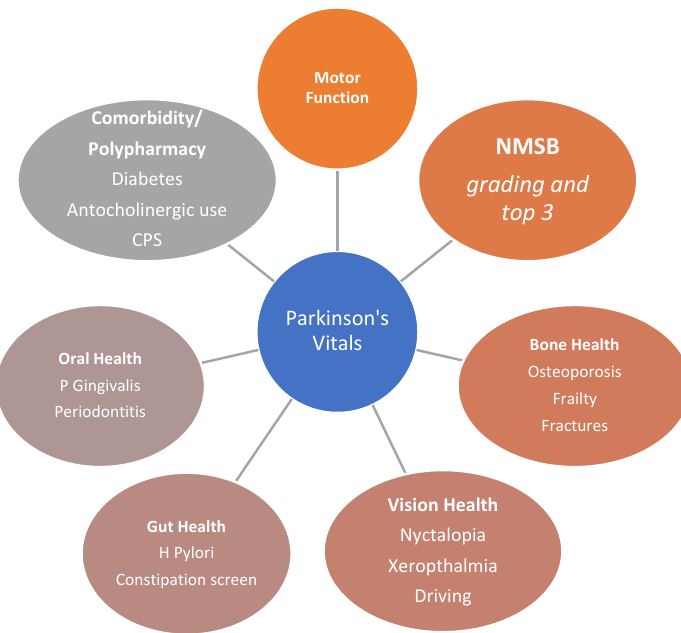
Figure 1. A diagram of the essential “vitals” to be considered in Parkinson’s disease which should form a dashboard of symptoms to be considered and managed in every person with Parkinson’s. NMSB non-motor symptom burden; H Pylori Helicobacter pylori; P Gingivalis porphyromonas gingivalis; CPS comorbidity polypharmacy score.